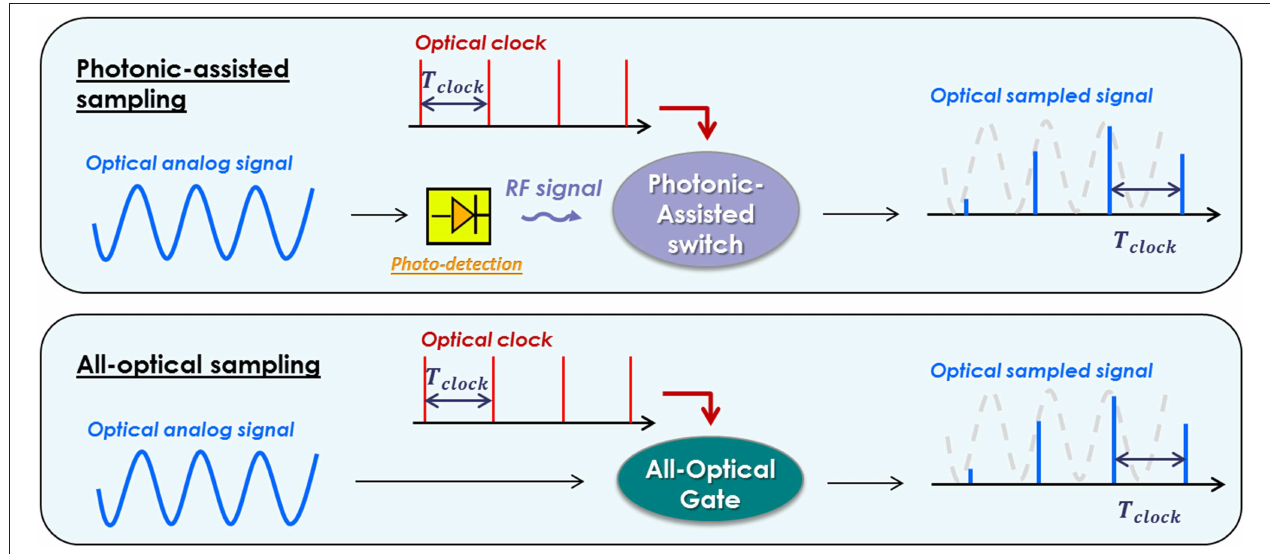
FIGURE 7 | Comparison between photonic-assisted and all-optical sampling. Photonic-assisted switches require an RF analog input, implying optical-to-electrical conversion of the incoming optical analog signal. In contrast, all-optical sampling devices can directly process optical signals, avoiding electrical conversion. In both configurations, at the output of the sampling device one retrieves the clock pulses modulated by the amplitude of the input analog